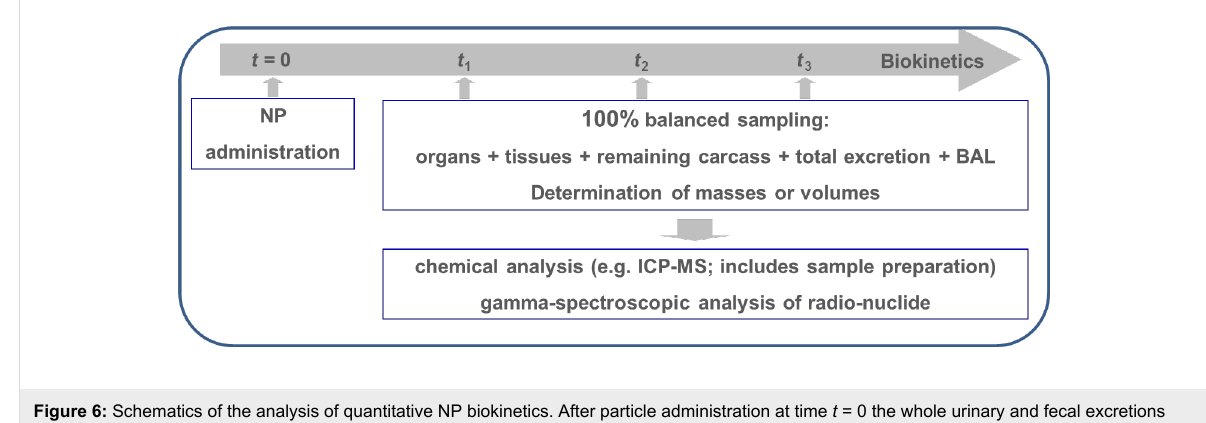
Figure 6: Schematics of the analysis of quantitative NP biokinetics. After particle administration at time t = 0 the whole urinary and fecal excretions are collected separately. Animals are euthanized at times t 1 , t 2 , t 3 , etc., and organs and tissues of interest and the entire remaining carcass are sampled (100% balanced sampling) and their weights or volumes are determined. Chemical analysis requires additional, separate steps of sample preparation. When particles are radio-labeled, total organs and tissue samples including the entire remaining carcass will be analyzed directly by using gamma spectrometry without any further preparation. Adapted from